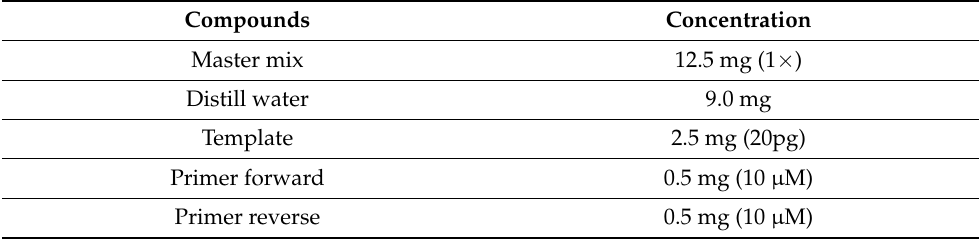
Table 2. Used compounds for PCR reaction.